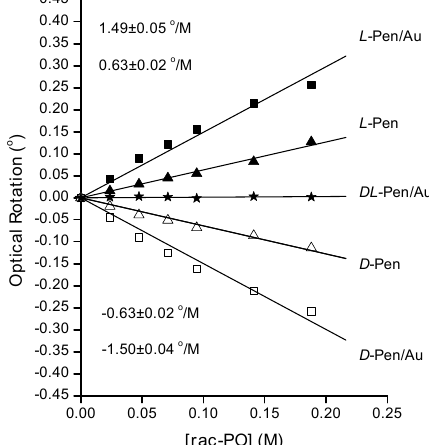
Figure 6. Optical rotation versus RS-PO concentration during addition to solutions containing Au-NPs coated with L-Pen ( ■ ), D-Pen (□) and DL-Pen ( ⋆ ). Addition of RS-PO to solutions containing enantiomerically pure D-Pen (Δ) and L-Pen ( ▲ ) indicates some interaction between PO and Pen. The concentration of Au was 0.24 M and the concentration of D-, L- and DL-Pen was 0.025 M. The structures of L-/D-Pen and L-/D-Cys are very similar, differing only in that Pen has two